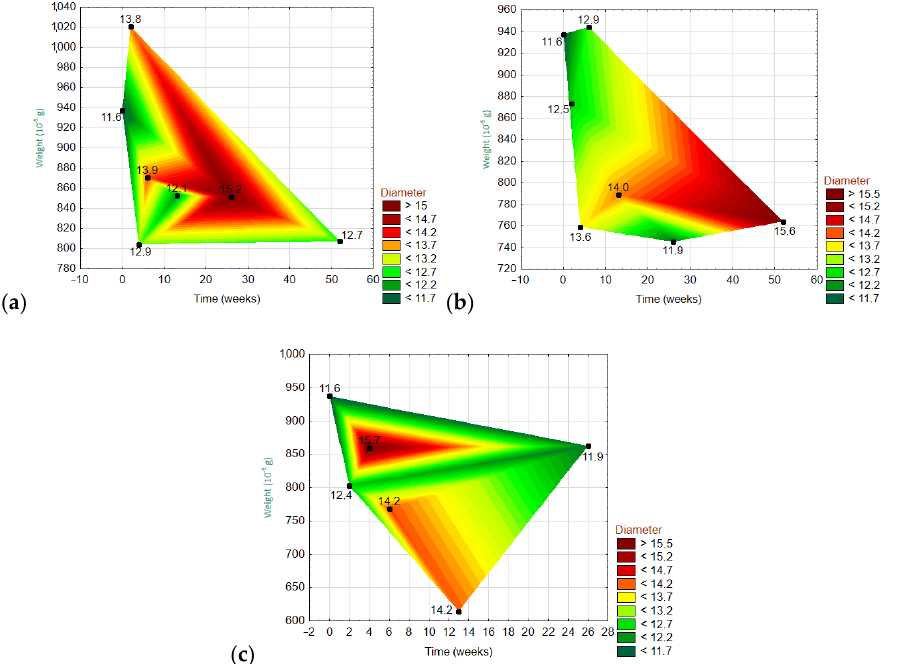
Figure 12. Three-dimensional wafer plots showing the dependencies of the three variables (diameter, weight, and time) for ARGFs treated with different solutions: ( a ) H 2 O, ( b ) Ca(OH) 2 , and ( c ) K 2 SiO 3 (bottom).